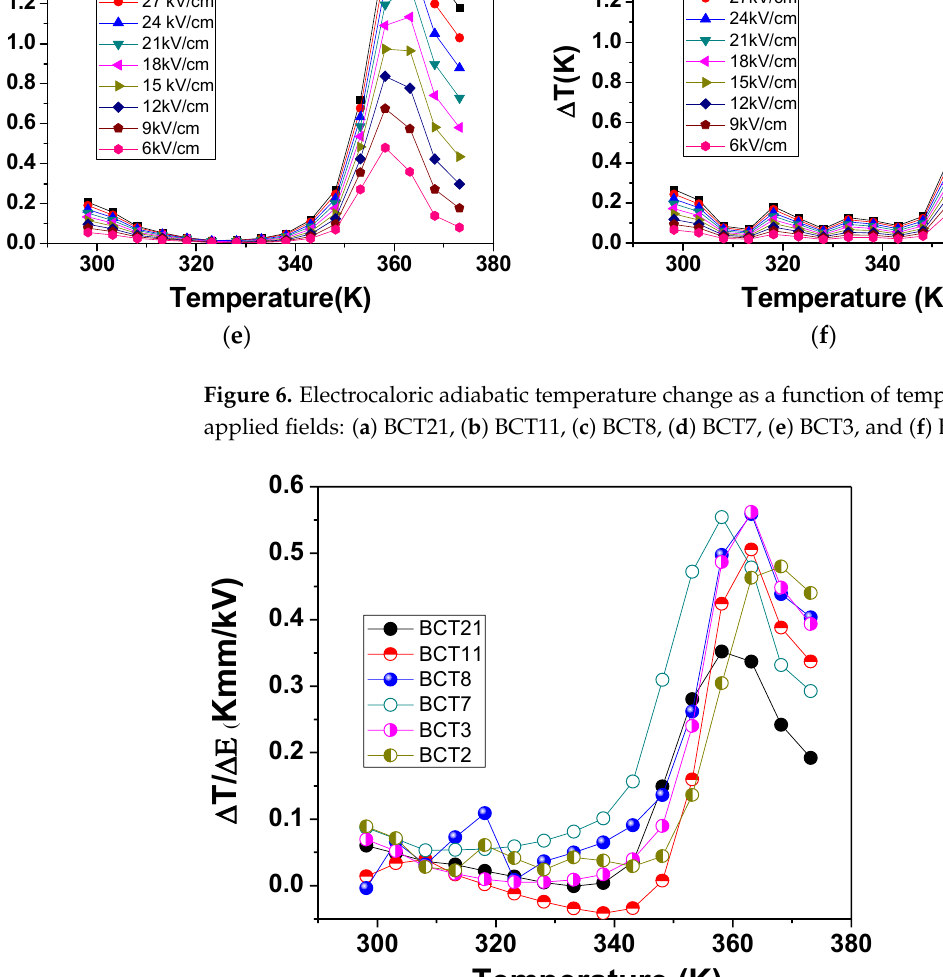
Figure 7. Electrocaloric responsivity as a function of temperature.